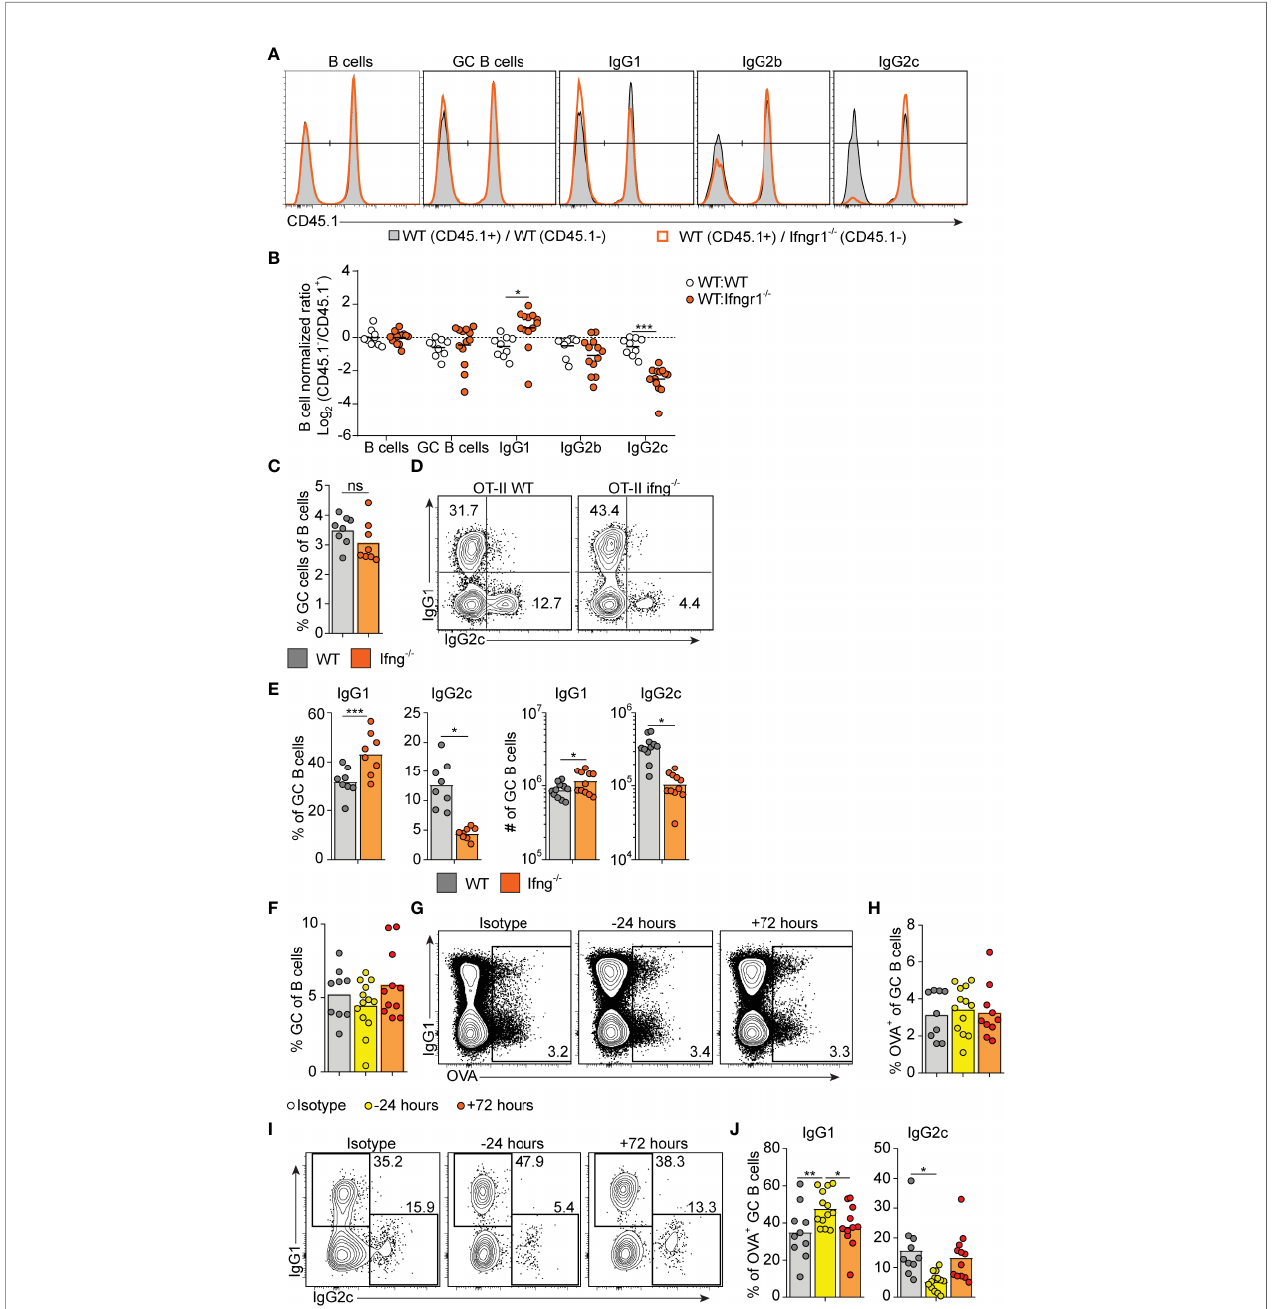
FIGURE 3 | Early IFN- g derived from cognate CD4 T cells acts on B cells to drive IgG2c CSR. (A, B) Mixed BM chimeras were generated by reconstituting WT recipients with a 1:1 mix of CD45.1 + CD45.2 + WT and CD45.1 - CD45.2 + WT or Ifngr1 - /- BM cells. Eight - 10 weeks after reconstitution, chimeras were immunized with OVA/poly I:C and the proportion of CD45.1 + versus CD45.1 - cells among total splenic B cells and within indicated GC B cell population determined by fl ow cytometry 8 dpi. (A) Representative results for control (WT : WT) and experimental (WT : Ifngr1 - /- ) BM chimeras. (B) Pooled results of log 2 normalized CD45.1 - to CD45.1 + cell ratio in individual control and experimental chimeric animals. (C – E) Ifng -/- mice were transferred with 50 000 WT or Ifng -/- OT-II cells and immunized with OVA/poly I:C. Splenocytes were analyzed by fl ow cytometry 8 days later. (C) Percentage of GC B cells of total B cells. (D, E) IgG subclass expression by GC B cells. Representative contour plots (D) and pooled results of percentages and numbers of IgG1 + and IgG2 + GC B cells (E) . (F – J) WT mice were treated i.p. with 1 mg anti-IFN- g mAb or isotype control 16 hrs before or 72 hrs after immunization with OVA/poly I:C. Mice were transferred with 50 000 OT-II cells 16 hrs before immunization and splenocytes were analyzed 8 dpi. (F) Percentage GC B cells of total B cells. (G, H) Analysis of OVA-binding by GC B cells. Representative fl ow cytometry results of OVA-Alexa647 fl uorescence versus IgG1 expression (G) and pooled results of percentages of OVA + GC B cells (H) . (I – J) IgG subclass expression by OVA + GC B cells. Representative contour plots (I) and pooled results of percentages IgG1 + and IgG2 + GC B cells (J) . Pooled results from two (C – E) or three (A, B, F – J) experiments are shown. Each symbol represents one mouse. ns = not signi fi cant, *p ≤ 0.05 and